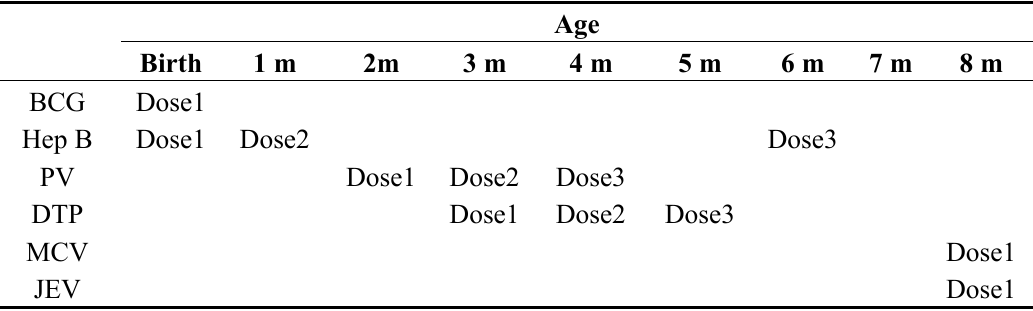
Table 1. Recommended childhood primary immunization schedule in